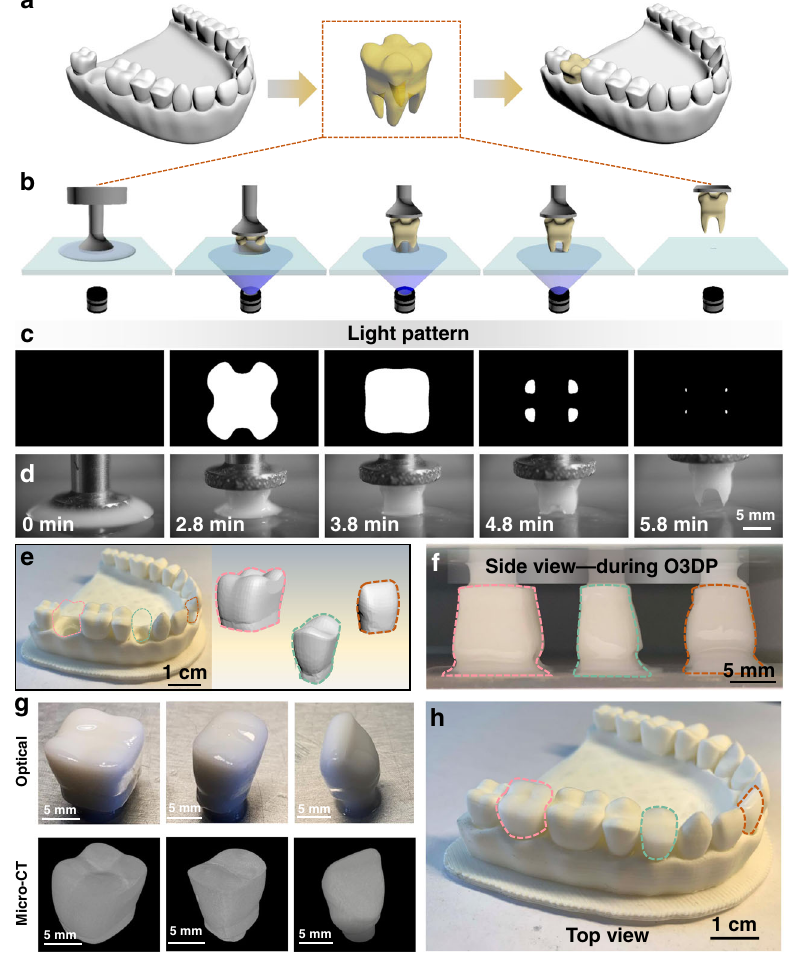
Fig. 4 Fine tooth structure fabricated through the one-droplet 3D printing process. a Scheme of the generation of the tooth model for the one-droplet 3D printing process. b , c Schemes ( b ), UV pattern sequences ( c ) and corresponding optical images ( d ) of the one-droplet 3D printing process, in which a resin droplet is cured into a desired tooth structure. e Scheme of the three selected crown structures and corresponding opposing dentition. Pink, green and orange indicate the crowns of a molar, a canine and an incisor. f Optical image of the one-droplet 3D printing process for printing arti fi cial crown structures. g Optical and micro-CT characterization of the printed crown structures, including the printed molar, canine, and incisor crowns structures. h Fixation of the printed crowns into the model with opposing dentition, with appropriate contact with adjacent teeth and marginal